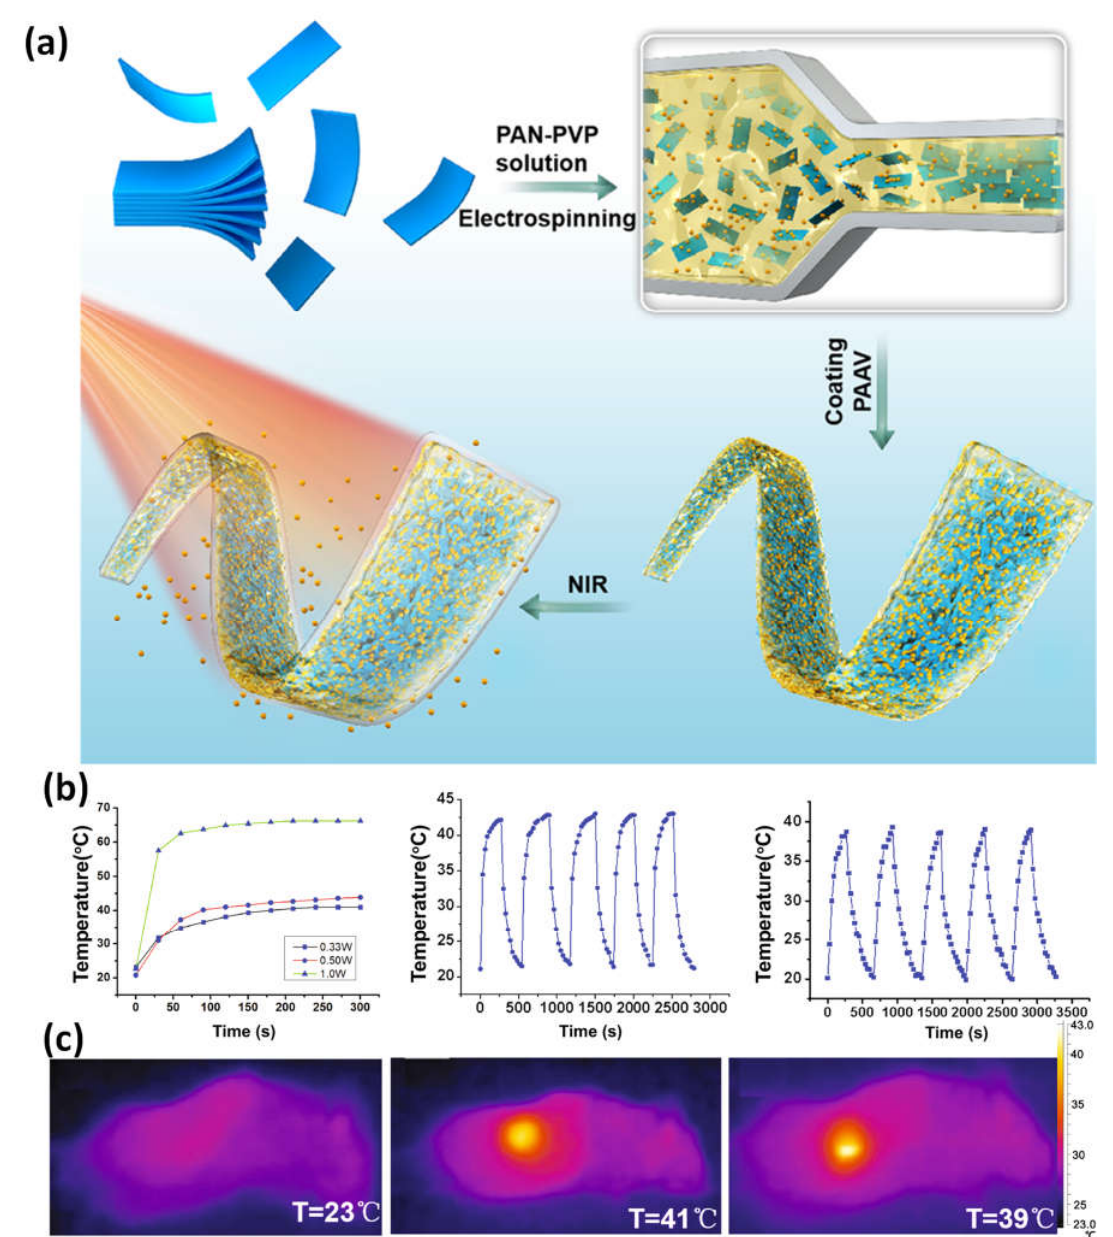
Figure 9. ( a ) A diagram showing how T-RMFs nanobelts are made and coated; ( b ) the RMFs' temperature growth profiles under NIR light (0.33, 0.50, 1.0 W), as well as the T-RMFs’ and RMFs’ temperatures over five on/off cycles; ( c ) thermal pictures taken with NIR light (0.33 W) of the comparison group, T-RMFs, and RMFs. Reproduced with permission from reference [87].